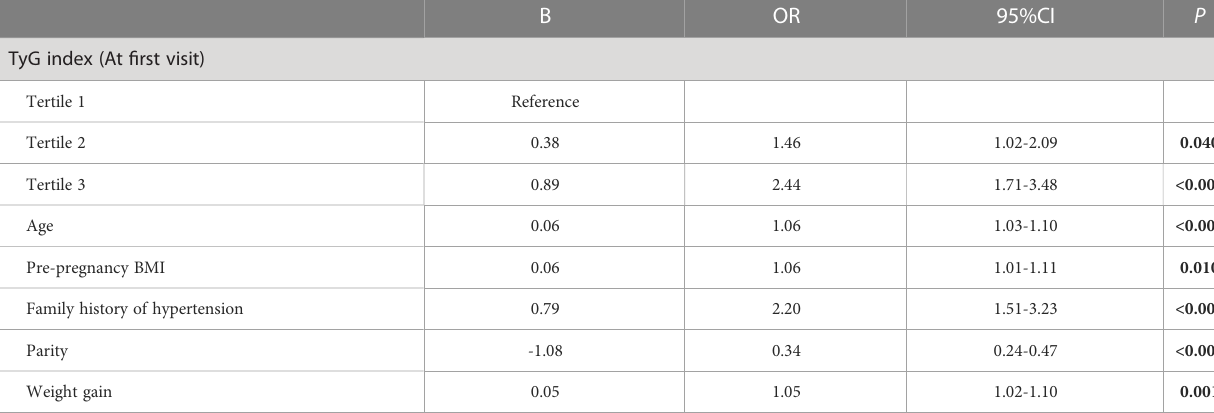
TABLE 2 Logistic regression analysis with enter selection for presence/absence HDP.